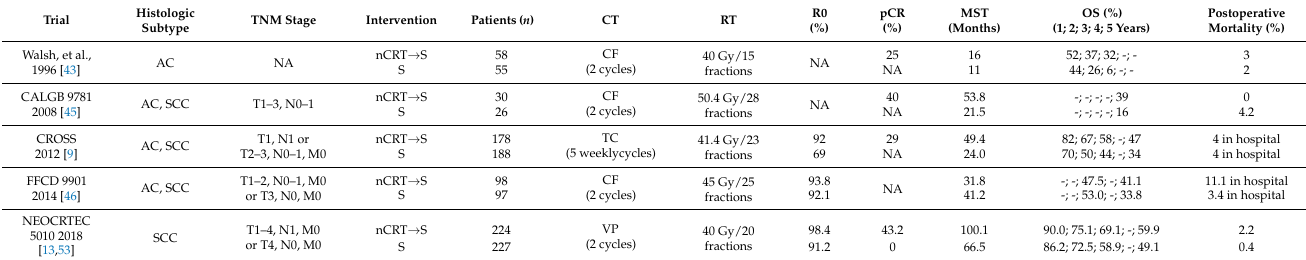
Table 3. Clinical trials of neoadjuvant chemoradiotherapy versus surgery alone for locally advanced resectable EC.